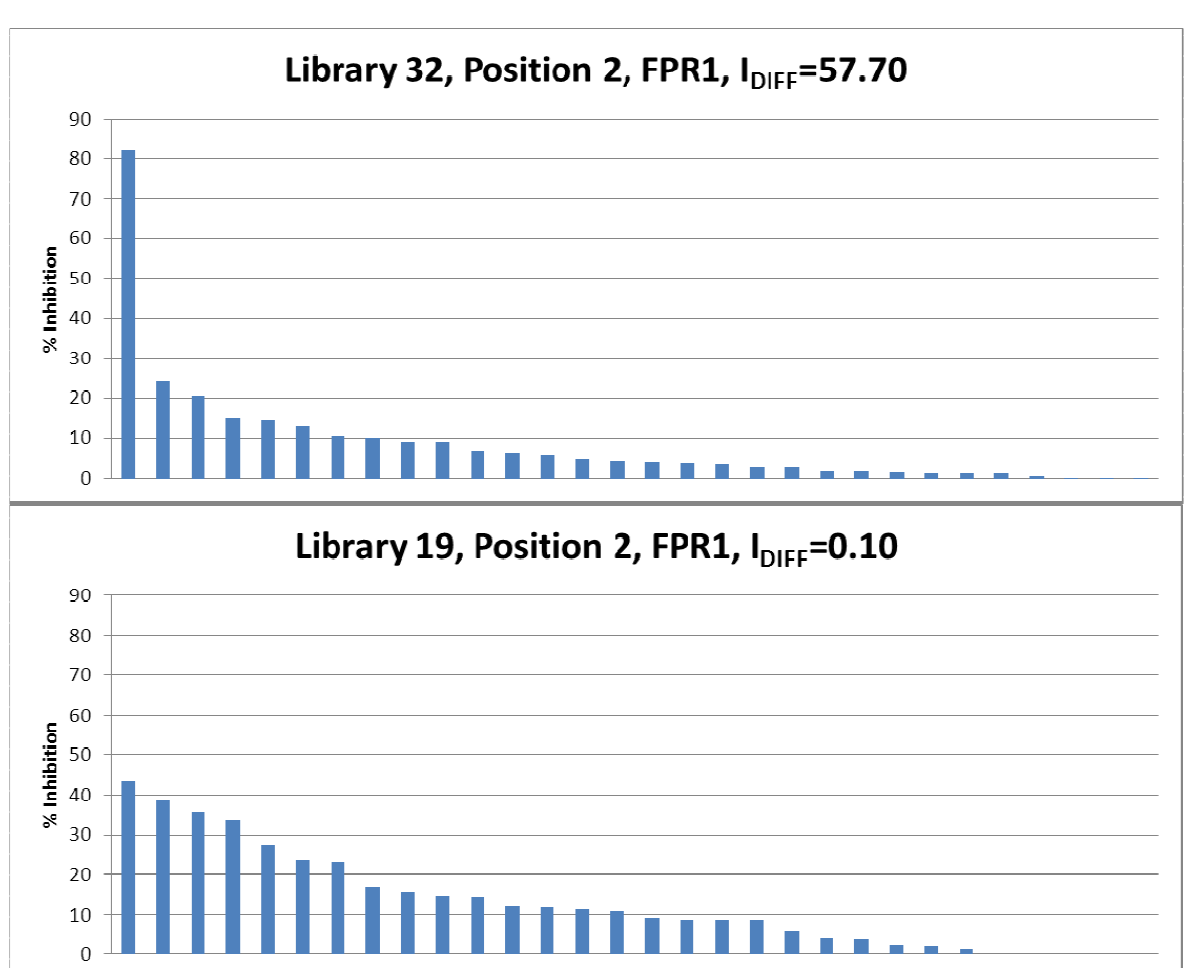
Figure 4. Examples of very high differentiation (Library 32, Position 2, for FPR1) and little differentiation (Library 19, Position 2, for FPR1) in positional scanning profiles, as defined in Equation (5). Note that overall, Library 19 exhibits more activity, but Library 32 is clearly more well-differentiated. Additional zero percent inhibition values have been removed from Library 32’s profile for